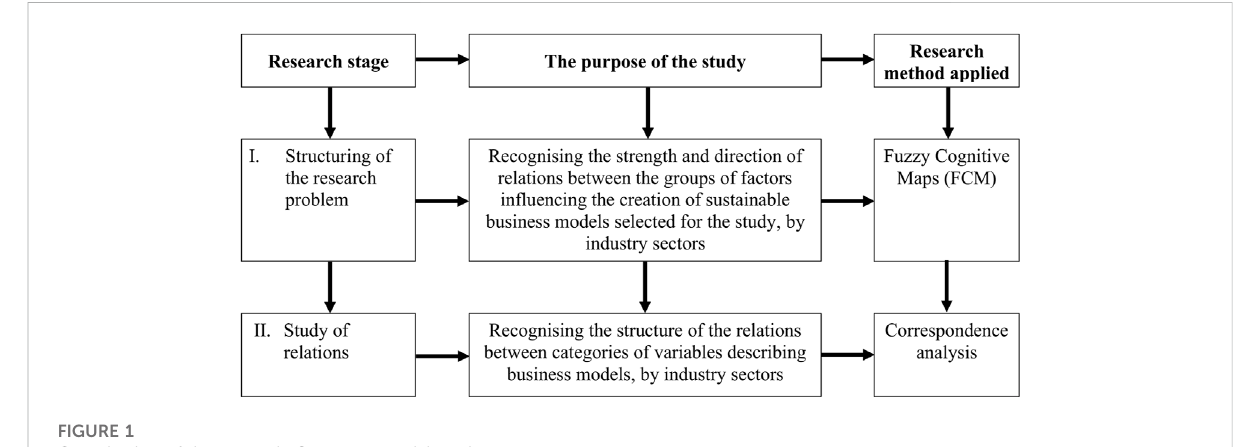
Organization of the research, Source: own